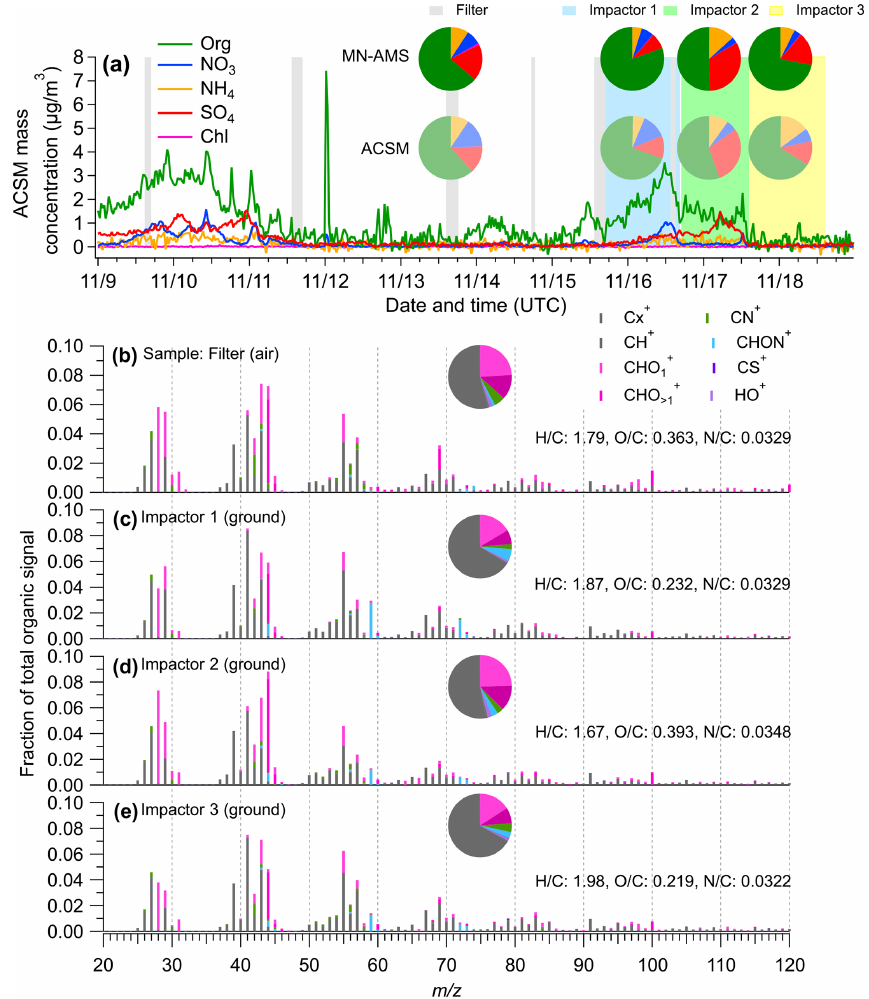
Figure 5. Comparison of offline PM 2 . 5 composition measured offline using the MN-AMS vs. the real-time PM 1 measured using a quadrupole aerosol chemical speciation monitor (ACSM). (a) Time series of the ACSM-measured NR-PM 1 species at the SGP site. The inset pie charts compare the composition measurements by the MN-AMS (darker colors) and the ACSM (lighter colors) for the same time periods. (b– e) High mass resolution organic spectra colored by eight ion categories for the SGP filter and impactors measured by MN-AMS. The average atomic ratios in the organics of each samples are shown in the legends.